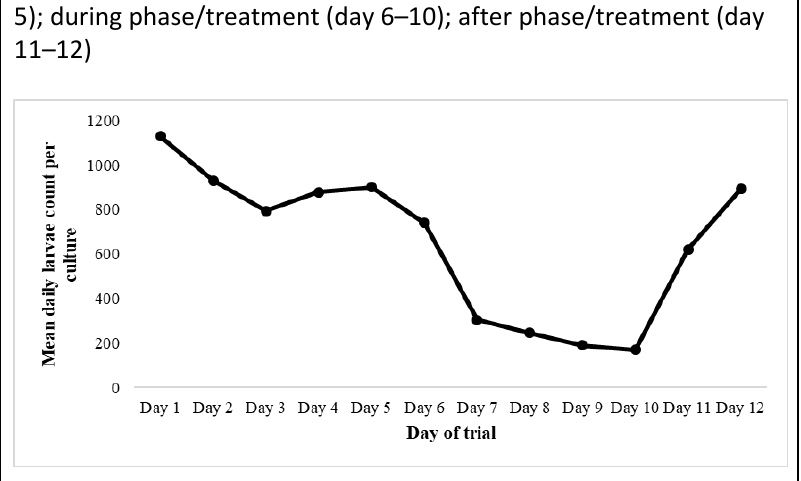
Figure 2: Mean daily larvae count. Nb. before phase/treatment (day 1–5); during phase/treatment (day 6–10); after